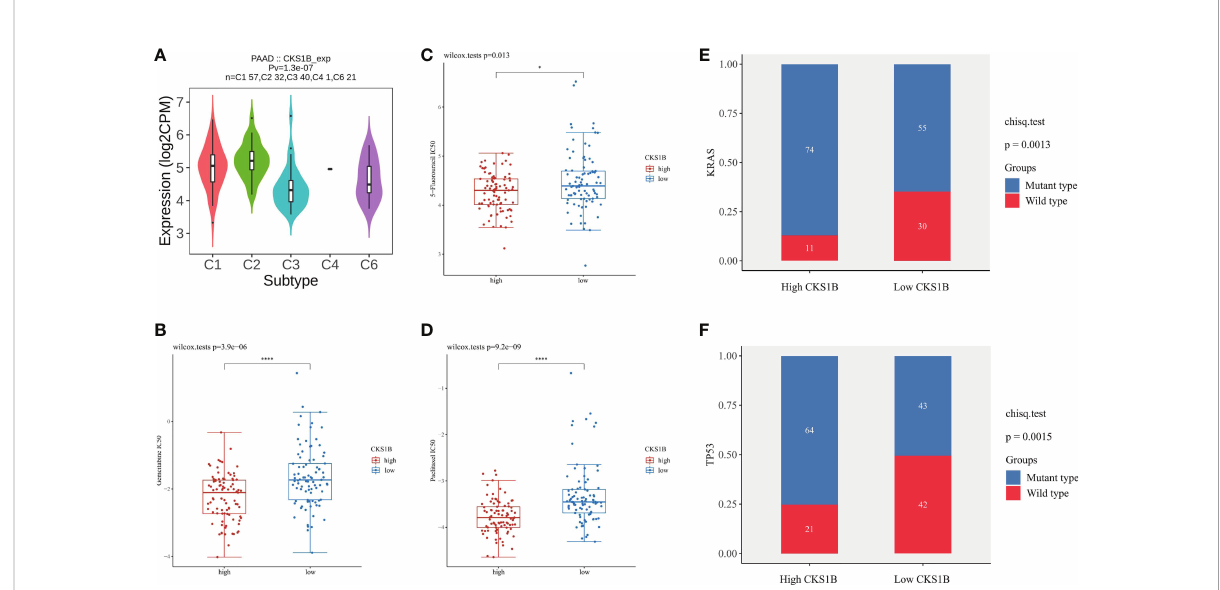
FIGURE 6 The chemotherapy sensitivity difference between high and low CKS1B group. (A) The relationship between CKS1B expression and pancreatic cancer immune subtypes. (B – D) The IC50 of common chemotherapeutic agents in high CKS1B and low CKS1B patients (gemcitabine, 5- fl uorouracil, and paclitaxel). (E, F) KRAS and TP53 mutation status in the high and low CKS1B groups. (*P < 0.05, ****P <